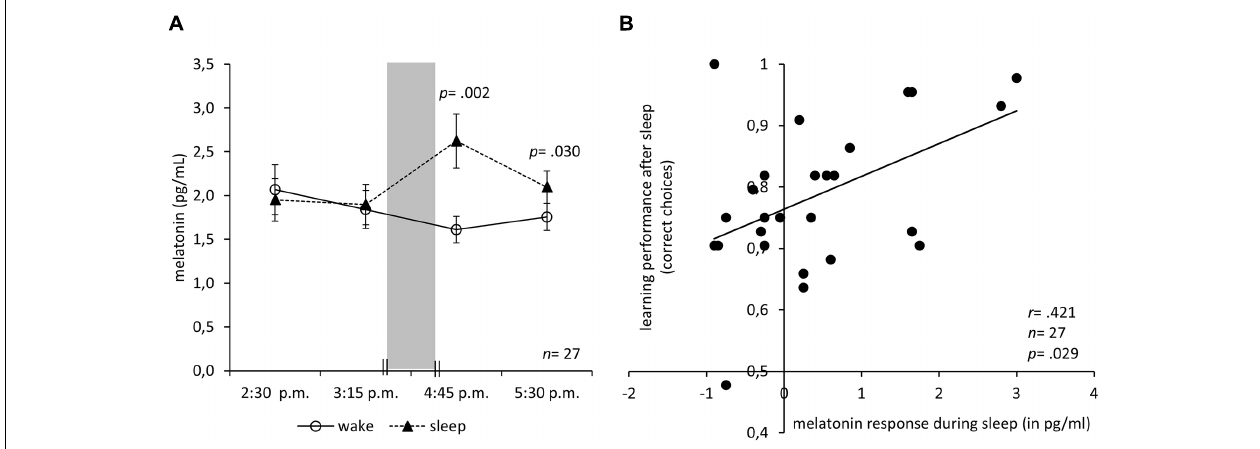
FIGURE 2 | Melatonin response during nap correlates with subsequent learning. (A) Mean and SEM of saliva melatonin levels before and after an interval either with sleep in darkness (nap condition) or wake in bright light (video condition). The 90 min sleep/wake interval is indicated by the gray bar. (B) Correlation of the melatonin response with the learning performance after the sleep interval in darkness (nap condition) with a regression line. Note that the guessing frequency is 0.5 correct